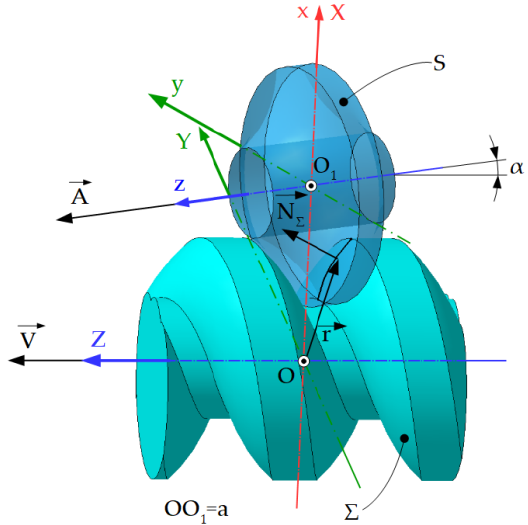
Figure 12. Disc tool-reference systems: xyz —fixed reference system, the z axis being superimposed on the axis of the rotation surface S ; X —mobile reference system, integral with the Σ surface, the Z axis being superimposed on the axis V at the initial moment, with the plane ZO 1 Y the mobile reference system is parallel to the plane zOy .